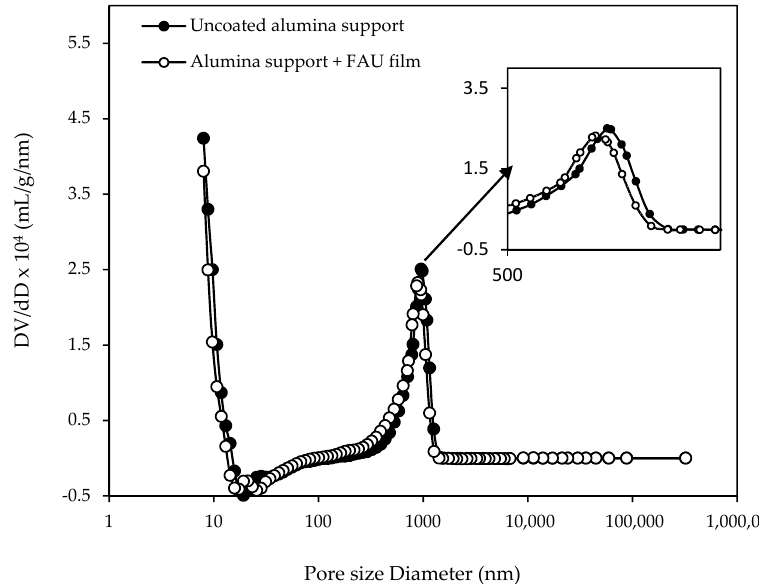
Figure 4. Pore size distribution of the uncoated alumina support (solid symbol) and the coated alumina support with FAU-type zeolite layer after 24 h of thermal treatment (empty symbol) performed by mercury porosimetry with a zoom on the region with pore size diameter between 500 and 1100 nm.